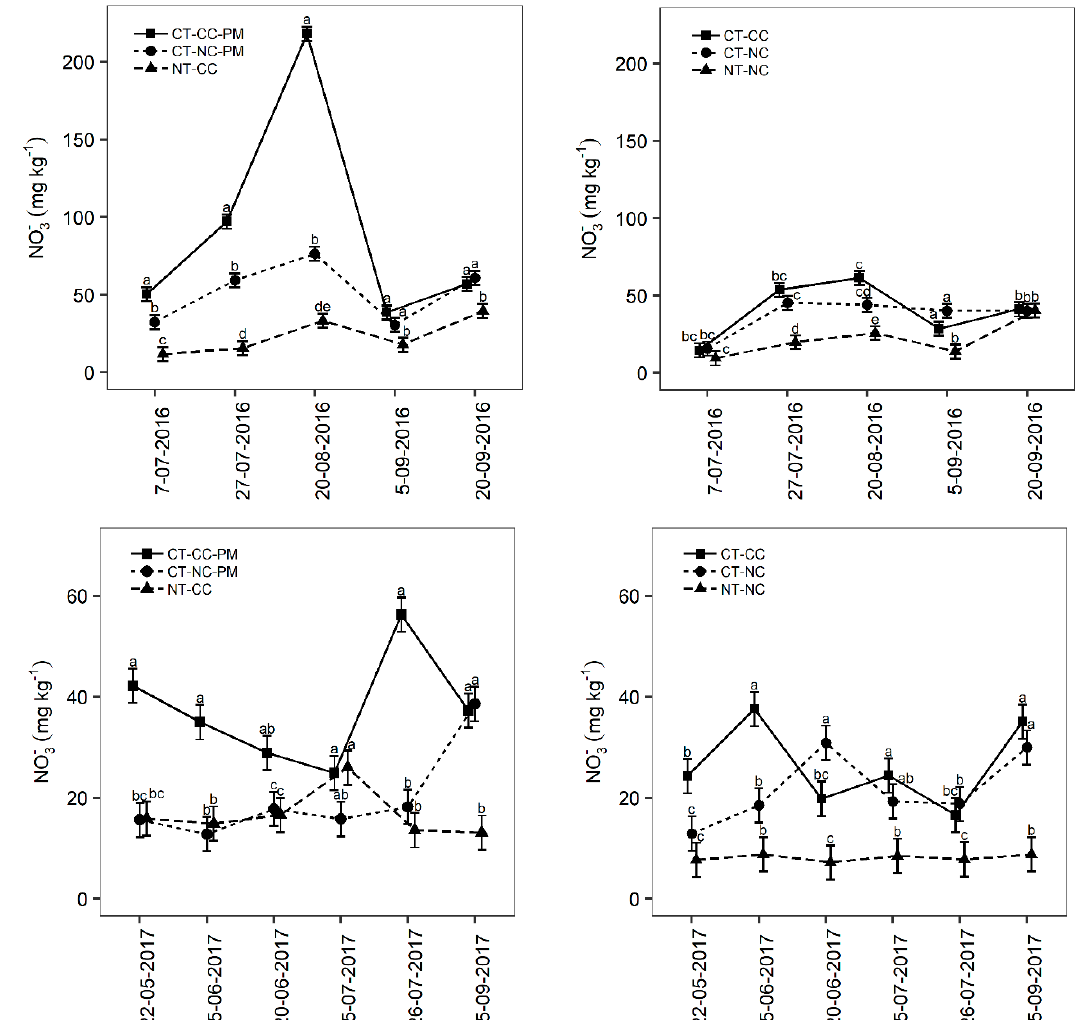
Figure 2. The soil nitrates concentration as affected by cover crop residues management in 2016 ( upper charts ) and 2017 ( lower charts ) trials. Letters of statistical significance correspond to treatments comparison within the same date of assessment. Values followed by different letters are significantly different at p < 0.05.